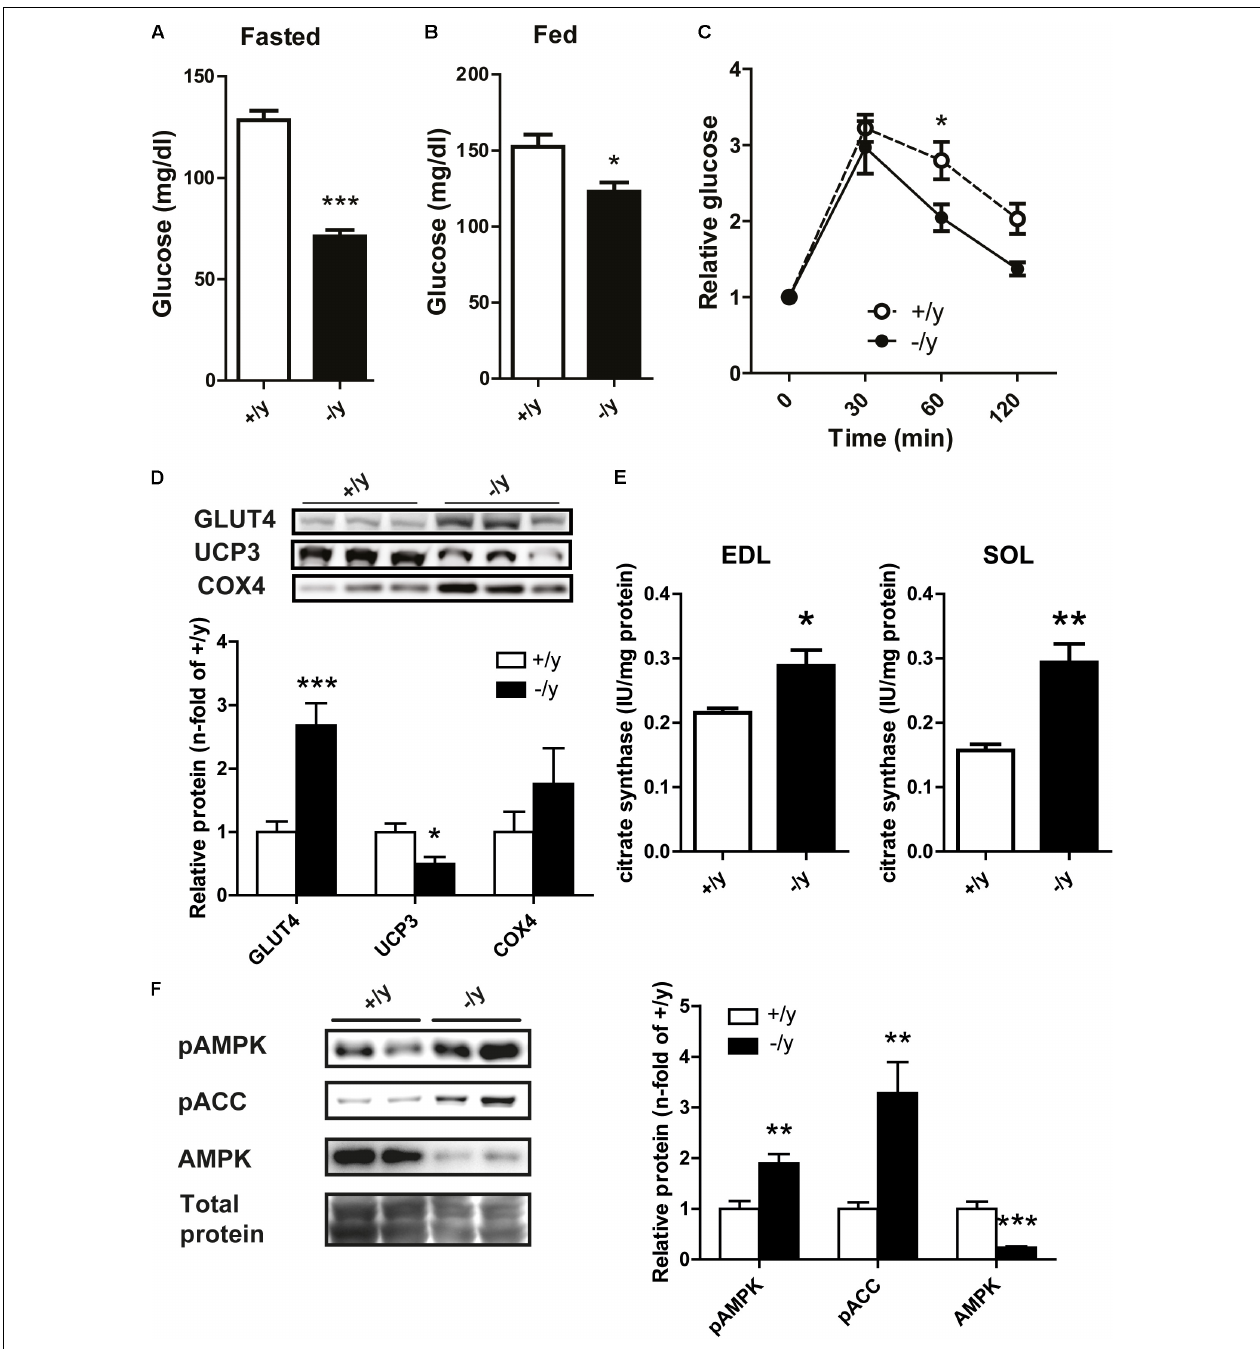
FIGURE 6 | Glucose metabolism and protein expression. (A,B) Fasted and fed blood glucose levels in CT1 + / y and CT1 − / y mice. (C) Glucose tolerance test normalized to fasted blood glucose levels ( n = 8–9). (D) Relative protein expression of muscle GLUT4, UCP3, and COX4 ( n = 6). (E) Citrate synthase activity in extensor digitorum longus (left) and soleus (right) muscle ( n = 4–5). (F) Protein levels of pAMPK, pACC, and AMPK in muscle tissue ( n = 6–8) ( ∗ P < 0.05; ∗∗ P < 0.01; ∗∗∗ P <